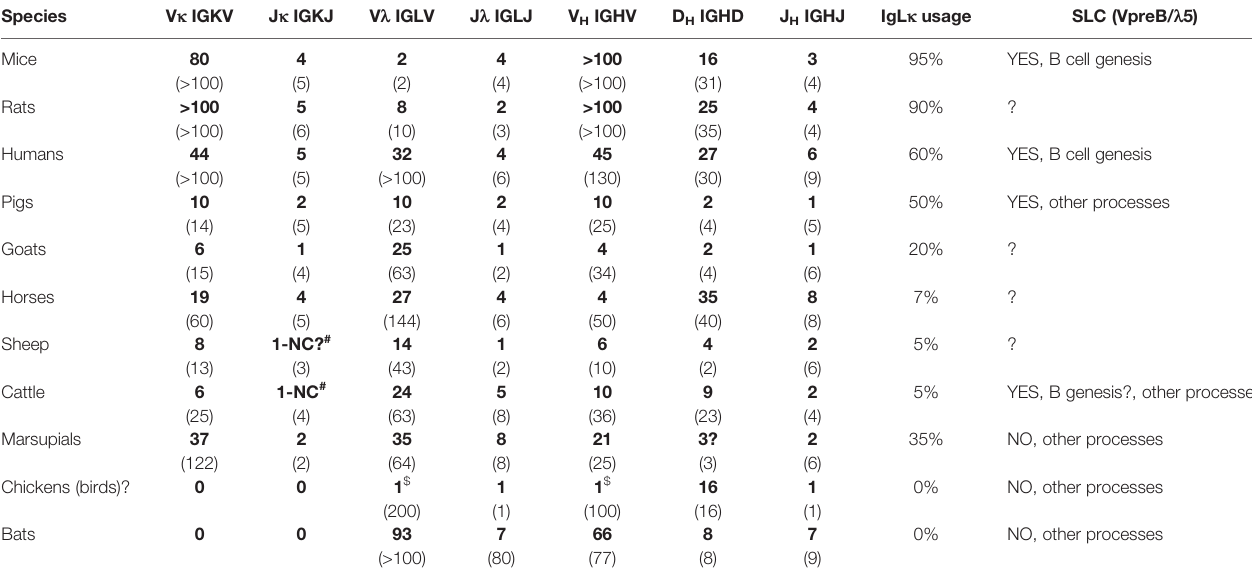
TABLE 1 | Number of biologically functional (and total) gene segments in different species * .